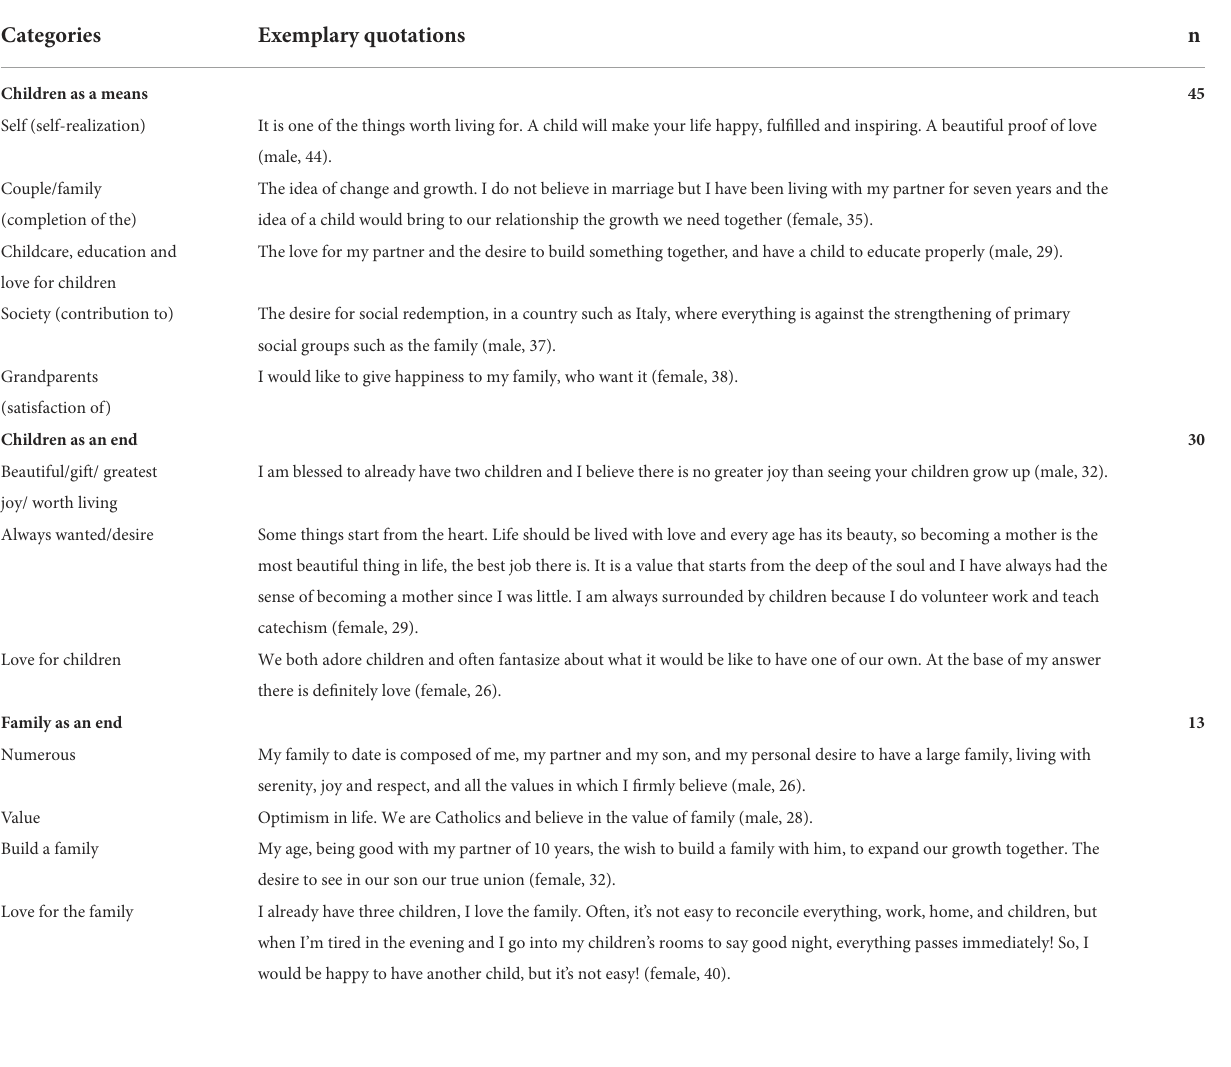
TABLE 5 Children and family imaginaries enabling fertility intentions ( N =